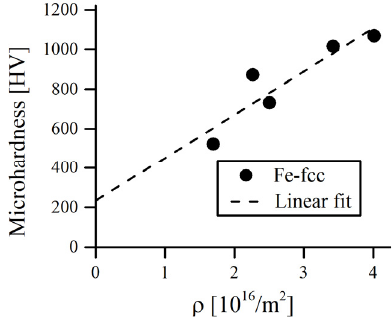
Figure 11. Relationship between dislocation density 𝜌 and powder microhardness 𝐻𝑉 . Dashed line is the linear fit of the data.